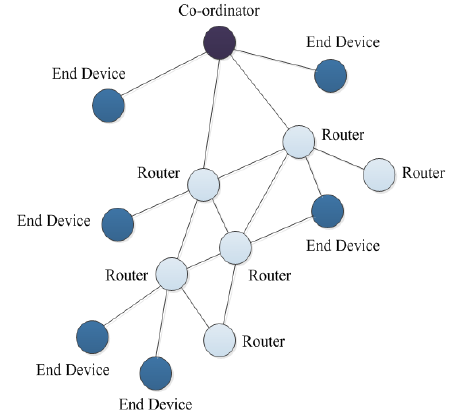
Figure 3. The schematic of mesh topology.